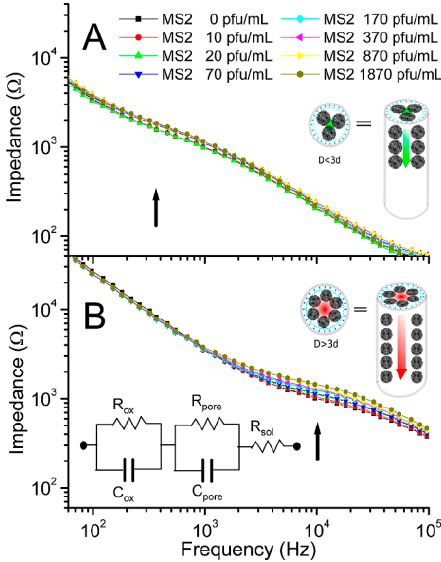
Figure 37. ( A ) Bode plots for different concentrations of MS2 bacteriophage. ( B ) It is shown that the smaller pores (73 nm) are less efficient due to compromised accessibility of the walls to viruses when the diameter of the pore is smaller than 3 times that of the virus, while larger pores (97 nm) are not affected. R sol is the resistance of solution above the membrane, R pore and C pore are the resistance and capacitance of the pores in the membrane, and R ox and C ox are the resistance and capacitance of the oxide layer. Adapted with permission from [190]. Copyright 2016 American Chemical